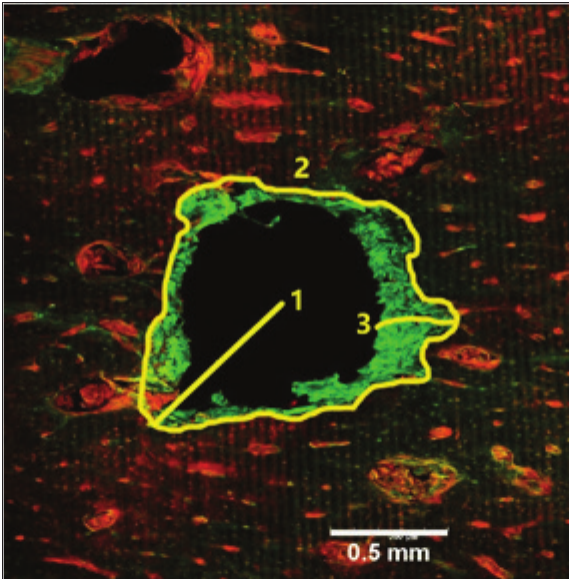
Figure 2. Laser confocal microscopy image of the exit surface damage caused by a pilot hole in 1.5 mm width bone. Measurements in mm